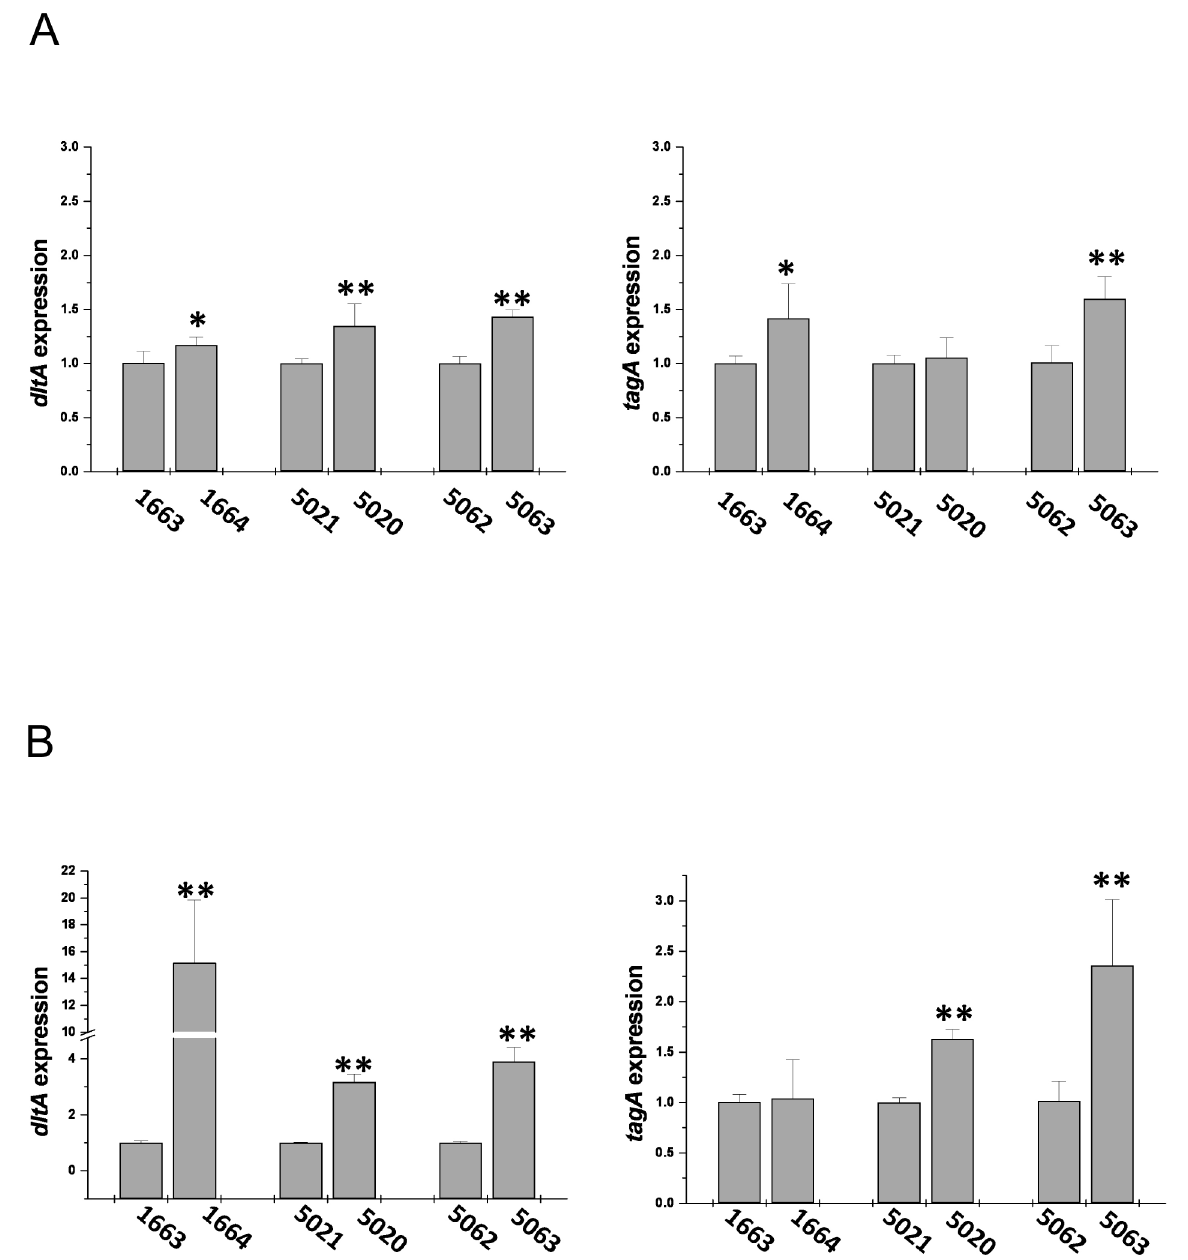
Figure 1. Expression profiles of dltA and tagA . Expression in exponential ( A ) and stationary growth phase ( B ). Values from exponential and stationary growth phase RNA samples were normalized vs. housekeeping gene, gyrB , expression levels; data from the DAP-S strains were set to 1 to allow comparison of data from different samples with their respective DAP-R isolates. *P < 0.05 and **P < 0.001.